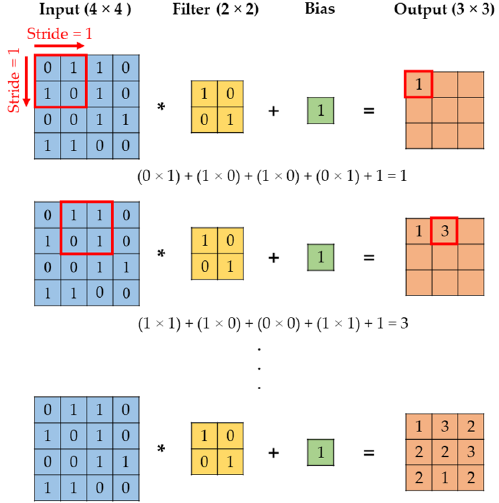
Figure 9. Convolution.